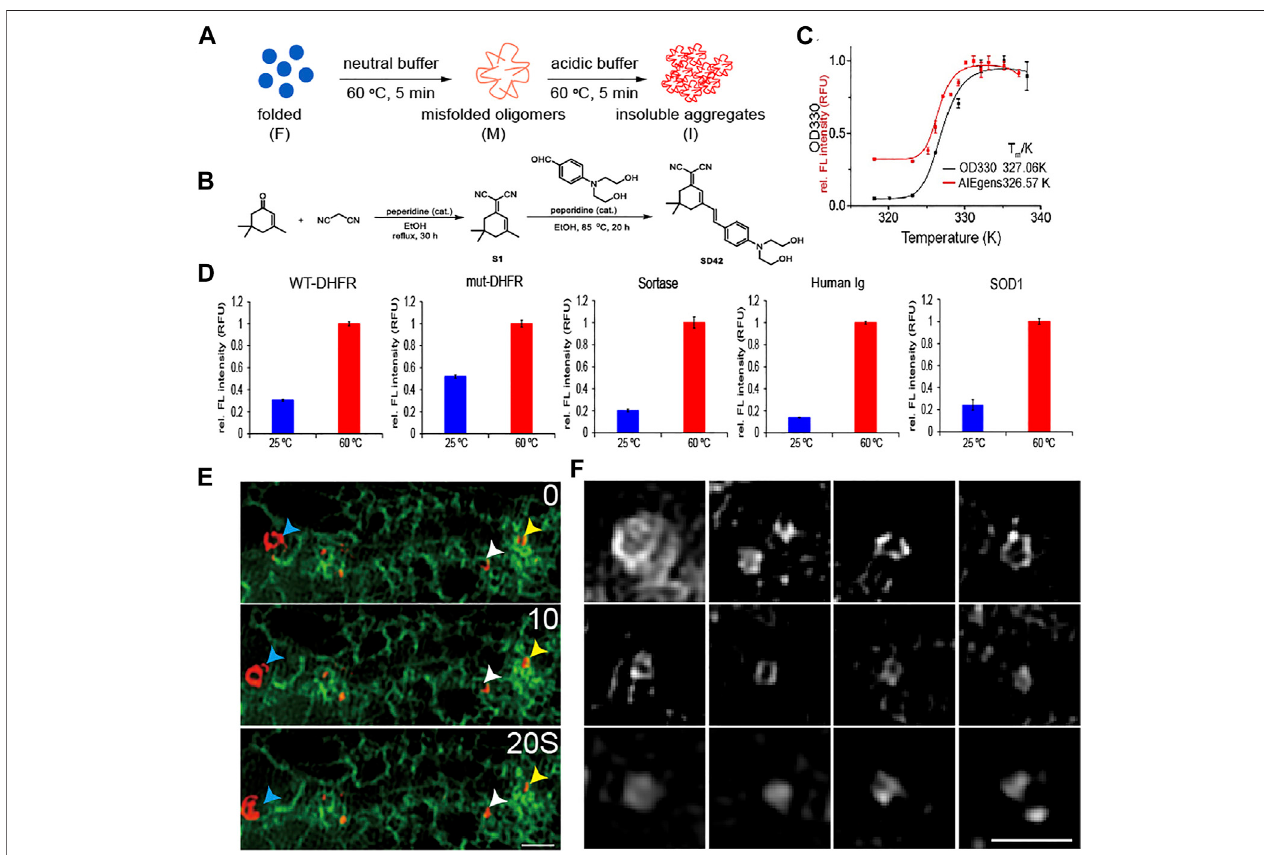
FIGURE3| Detectingunfoldedandaggregatedprotein invitro and invivo byAIEgen. (A) Acartoonillustrationoftheformationofmisfoldedoligomersandinsoluble aggregated DHFR model proteins. (B) Structural features of the AIEgen. (C) Thermal shift assay using OD330 turbidity (black curve) and the fl uorescence of the AIEgen (redcurve).FluorescenceofAIEgenoccursslightlyearlierthantheformationofinsolubleaggregatesmeasuredbyOD330turbidityassay,indicatingthatthe fl uorescence originates from misfolded oligomers. (D) Fluorescence of AIEgen detecting the folded verses misfolded and aggregated proteins. AIEgen (25 μ M) and WT-DHFR (50 μ M), mut-DHFR (50 μ M), sortase (50 μ M), Human Ig (1 mg/ml) and SOD1 (50 μ M) were mixed in acidic aggregation buffer (NaOAc 200 mM, KCl 100 mM, acidi fi ed byAcOHtopH (cid:1) 6.23)andincubatedat60 ° Cor80 ° Cfor5 min.Spectrawerecollectedwithanexcitationwavelengthof561 nm. (E) Bothmobile(bluearrowhead)and immobile(whiteandyellowarrowheads)unfoldedproteinsaretightlyassociatedwithER(green).Scalebar (cid:1) 1 μ m. (F) SIMmicroscopyshowsroundshapesofunfolded proteins. Scale bar (cid:1) 1 μ m.